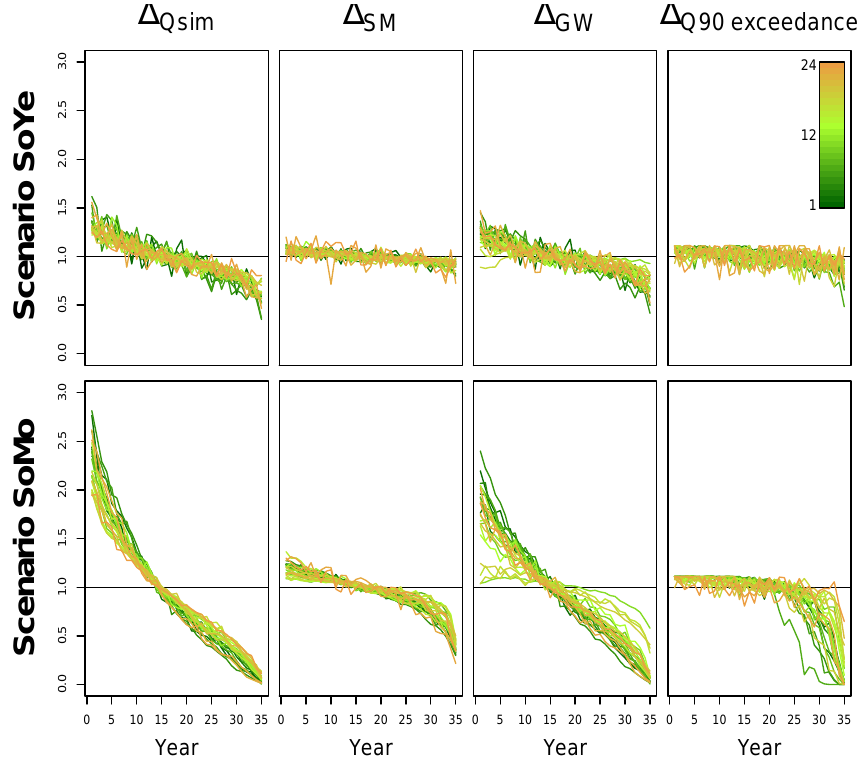
Figure 3. Relative change of Q sim , SM and GW and the Q 90 exceedance days for the two scenarios to the long-term reference for all catchments. Each color stands for one catchment number (Table 1), where the greener colors indicate catchments at the lower mean elevation and the more brownish colors were used for catchments at higher mean elevation. Note that the upper boundary of the relative change of Q 90 is given by the fixed days that are exceeding Q 90 per year and the maximum days per